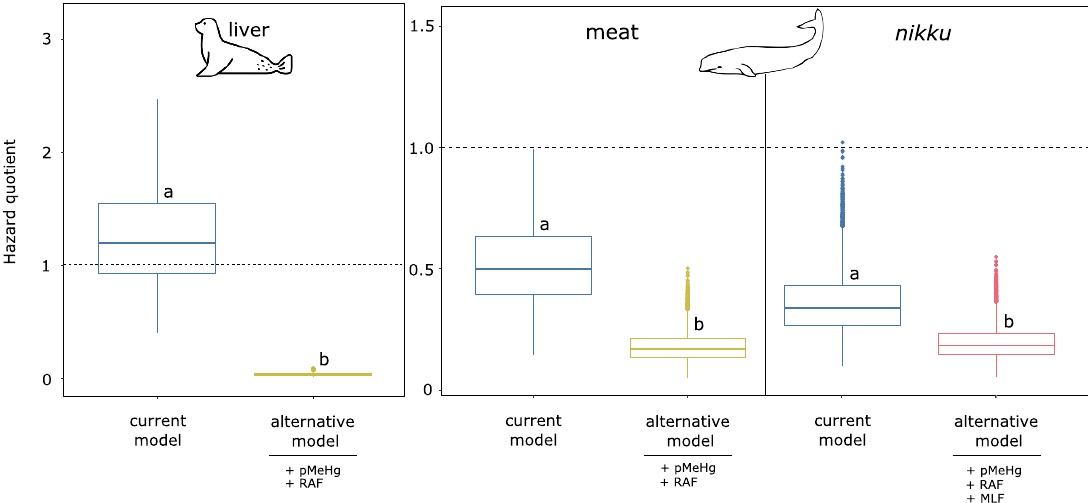
Figure 2. Hazard quotient as function of marine mammals consumed and as function of the variables used in the assessment of MeHg exposure for the sensitive Indigenous population. Letters are used to indicate a significative difference ( p < 0.05) between a given scenario. See Table S1 for the details of variables used for each scenario. pMeHg: proportion of THg that is methylated; RAF: relative absorption factor; MLF: mass loss factor.